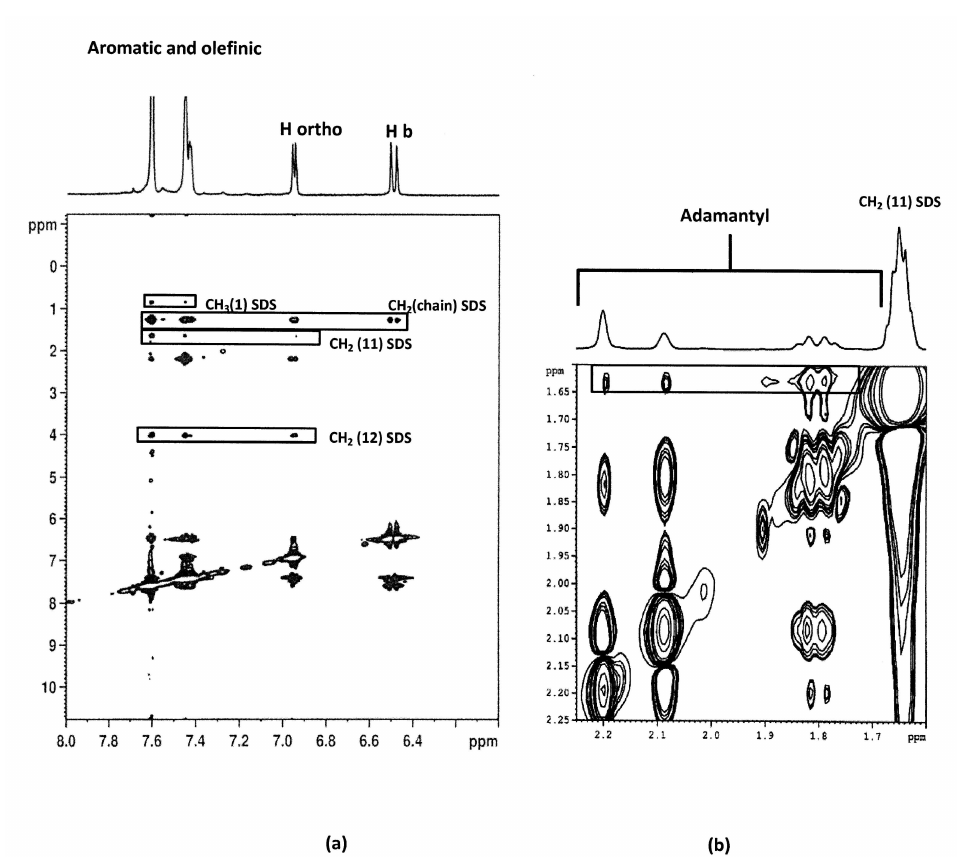
Figure 4. 2D ROESY spectrum of adarotene + SDS in D2O, T = 25 ◦ C. The boxes indicate the intermolecular NOEs between SDS micelles and ( a ) aromatic and olefinic protons and ( b ) adamantyl moety of